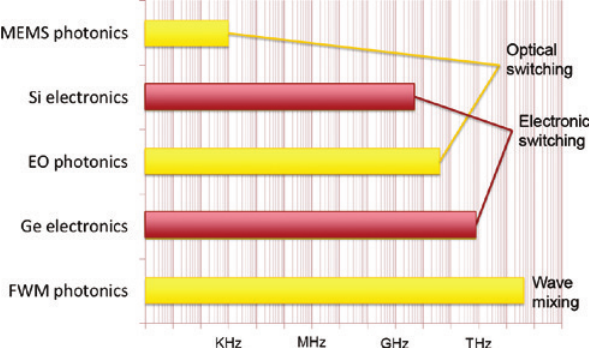
Figure 5: Domain impact on speed.